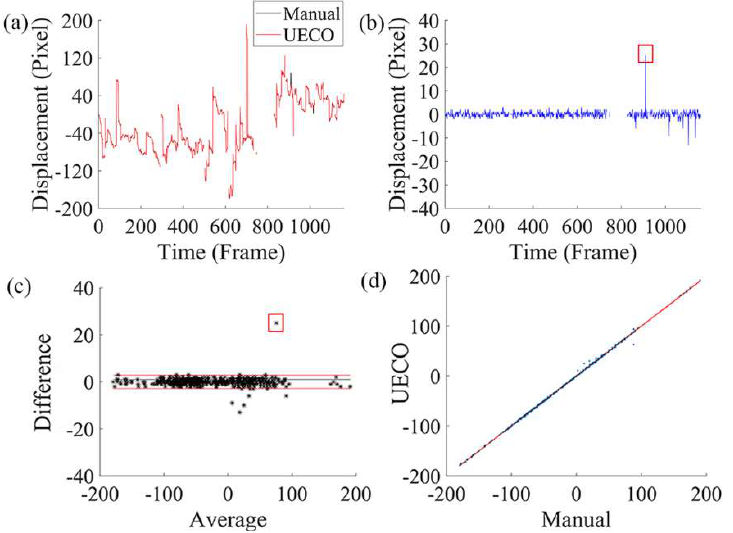
Figure 5. Vertical displacement comparison chart; ( a ) shows the comparison of the vertical displacements obtained by UECO and manual registration; ( b ) is the difference between the two methods; and ( c ) is the Bland−Altman plot. The black line is the mean difference of the two methods. Red lines indicate the 95% confidence interval (mean ± 1.96 × standard deviation). The Pearson correlation coefficient curve is shown in ( d ). The frames with the largest differences have been marked with red boxes. The frame number in the x-axis corresponds to the frame number in the original video.